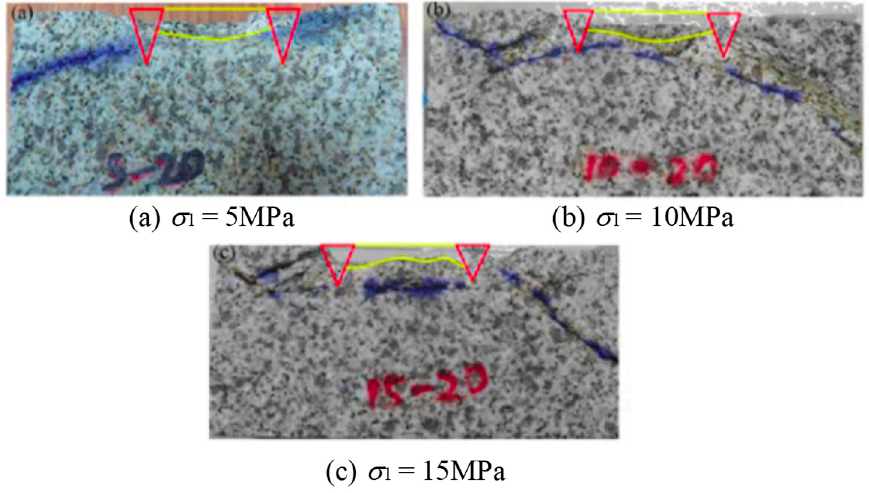
Figure 9. Crack development in the cross section with increase of σ 1 , while σ 2 is 20 MPa.